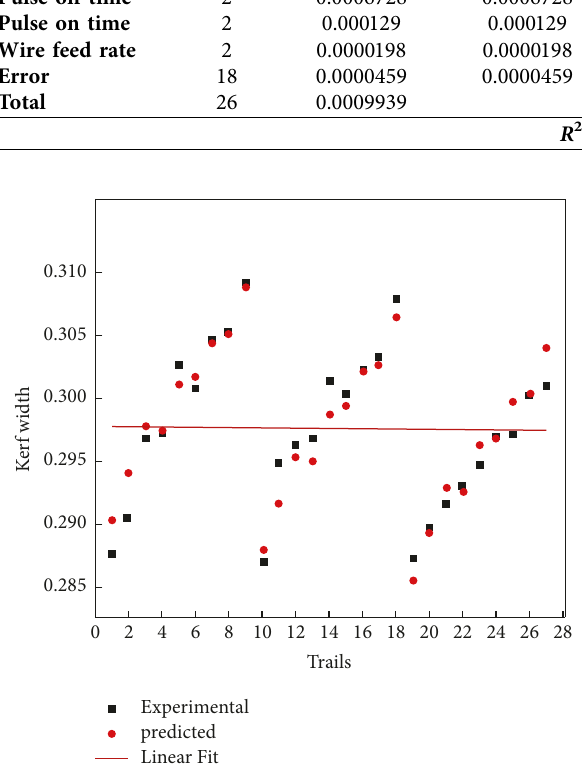
Figure 7: Variation between experimental and predicted values of Kerf width.